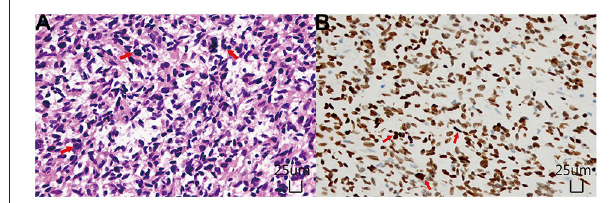
FIGURE 2 | Histopathological examinations. (A) Hematoxylin and Eosin staining ( × 200) showed diffusely distributed tumor cells with unobvious atypia and no karyokinesis. (B) Immunohistochemical staining ( × 200) demonstrated that the tumor cells were positive for H3K27M mutant protein, and the positive site was located in the nucleus.